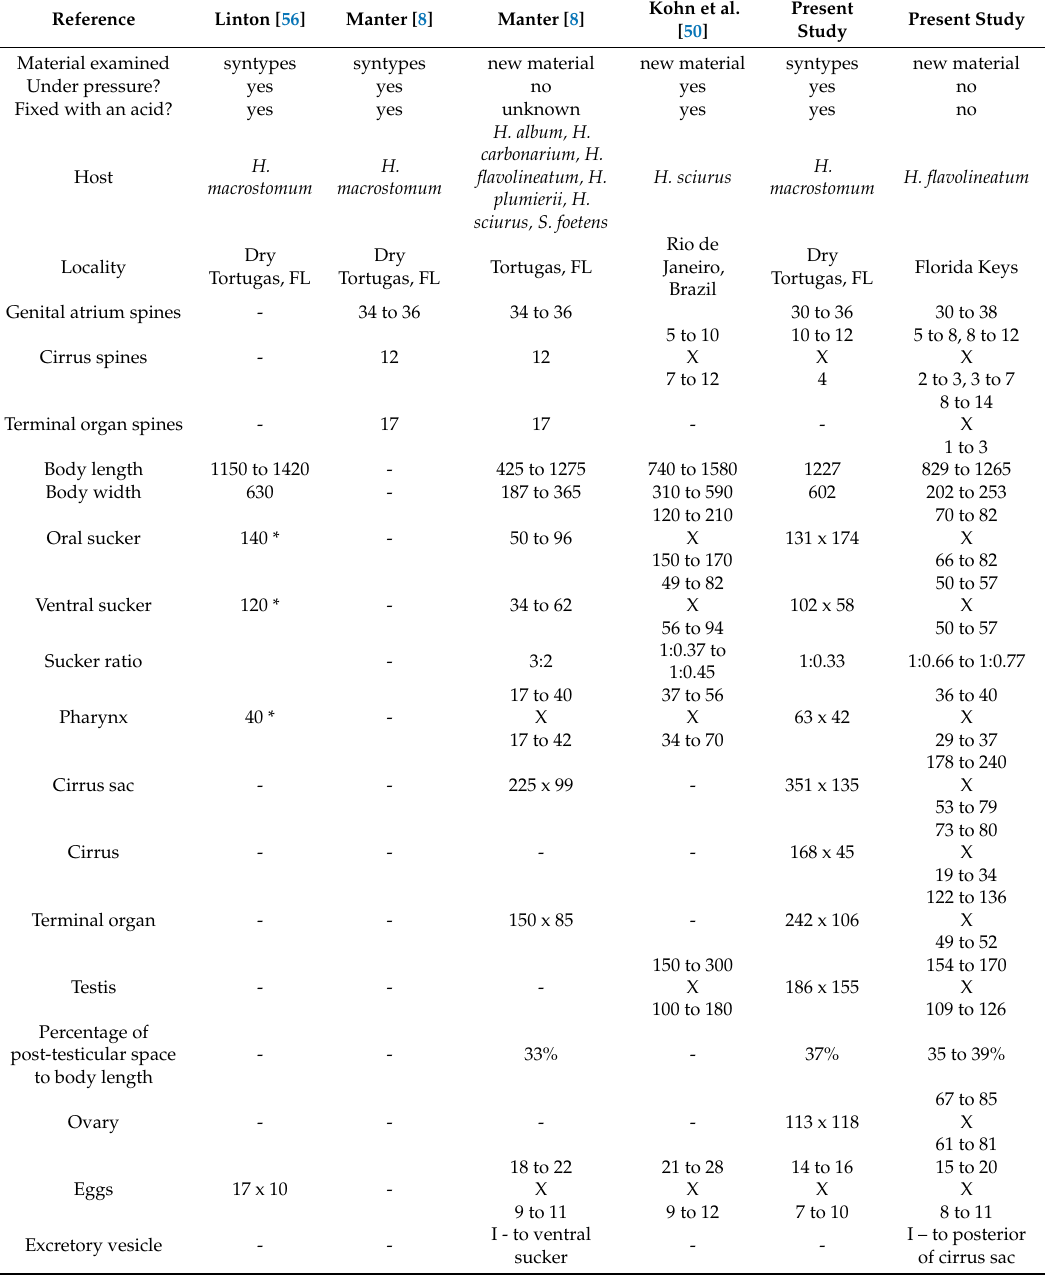
Table 2. Comparison of measurements of Genolopa ampullacea . Measurements in micrometers ( µ m), dimensions shown as length by